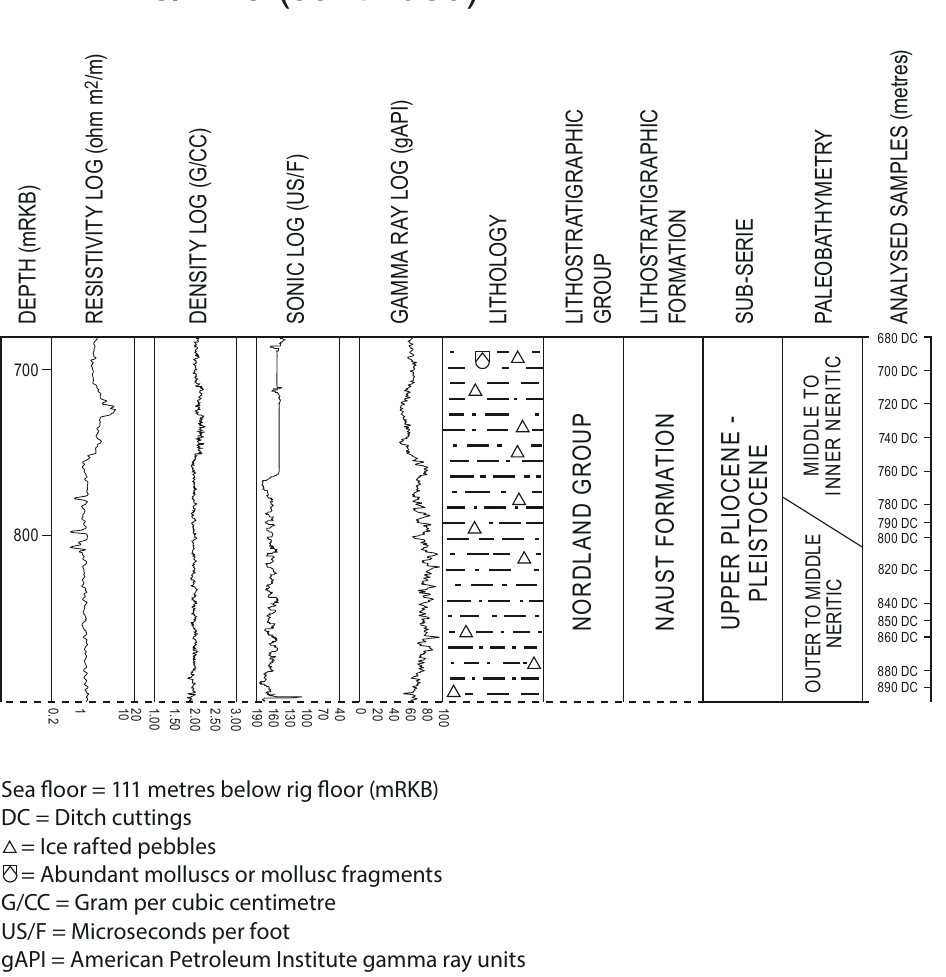
Figure 66. Well summary figure including resistivity log, density log, sonic log, gamma-ray log, lithology, litho- stratigraphic units, sub-series, paleobathymetry and analysed samples for the upper part of the investigated sequence in well 15/12–3 (upper Pliocene–Pleistocene) including the supplementary well reference section for the Naust Formation in the North Sea (modified after Eidvin et al., 1999,